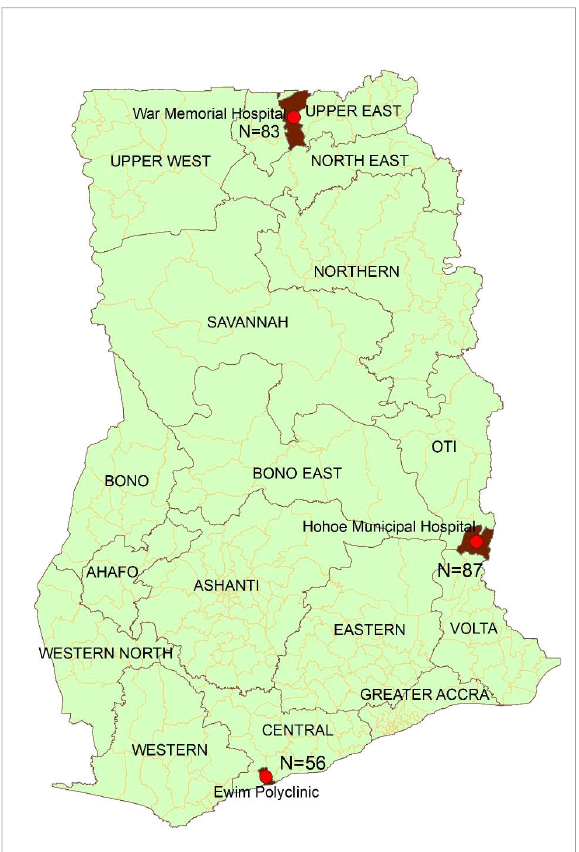
FIGURE 1 Map of Ghana showing the three sentinel sites as red